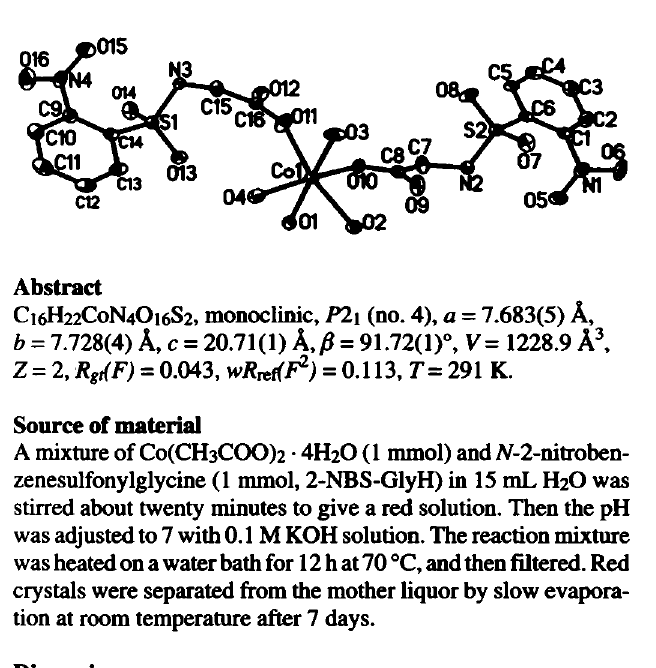
Table 2. Atomic coordinates and displacement parameters (in Ä 2